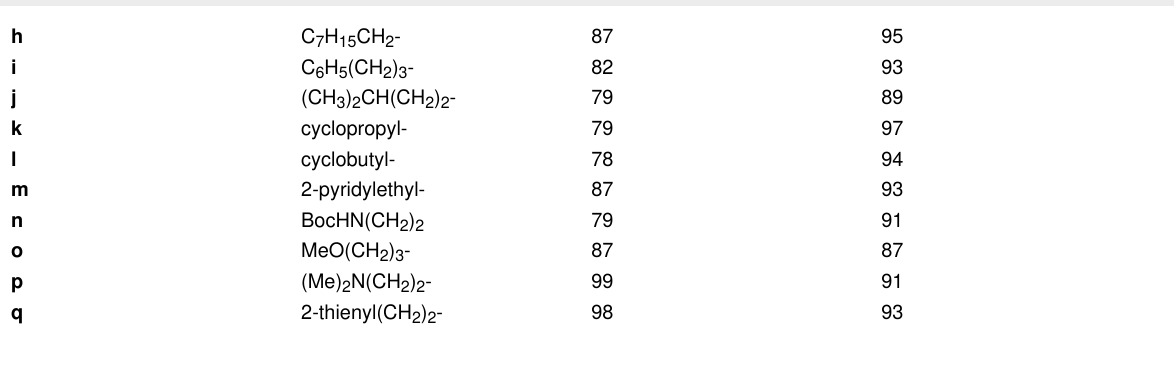
Table 23: Aza-Michael addition of primary amines to β -trifluromethyl- β -phenylnitroolefin catalyzed nitrogen heterocyclic carbene. (continued)